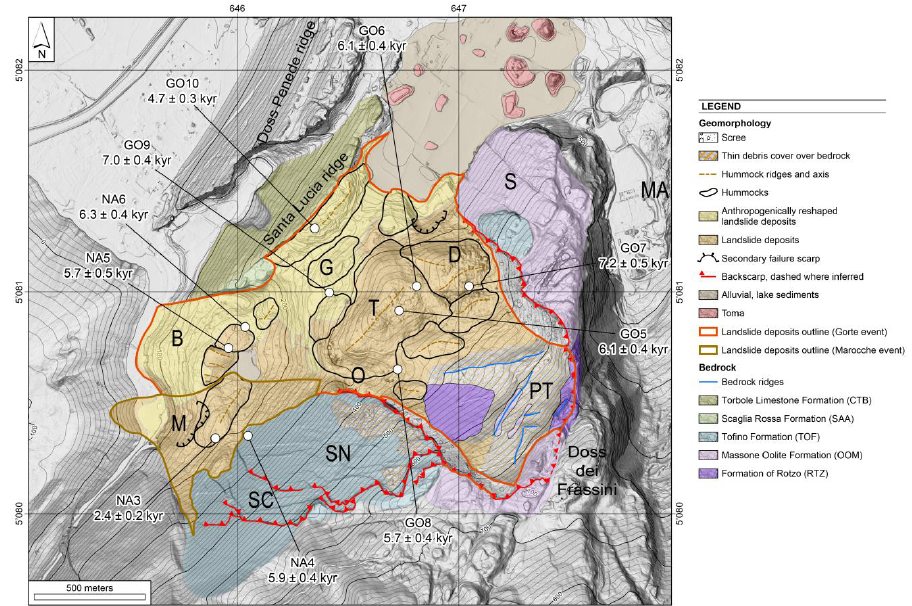
Figure 5. Geomorphological map of the study area. Boulders dated with 36 Cl and the calculated exposure ages are shown (Table 1). Samples NA4 (bedrock) and NA3 are from the Spiaz de Navesele event, and all others are boulders in the Gorte landslide deposits. B : Busatte, D : Daine, G : Gorte, M : Marocche, MA : Mala, O : Oltrezengol Valley, PT : Paternoster, S : Segron, SC : Salto della Capra, SN : Spiaz de Navesele, T : Tiro a Volo.